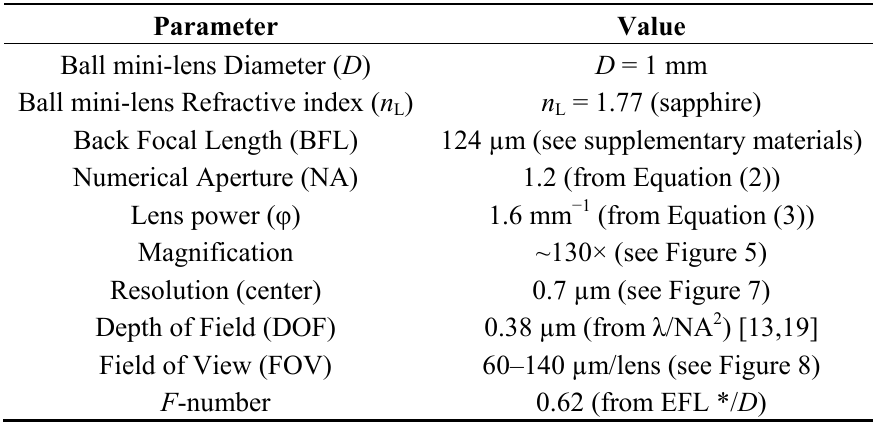
Table 1. Properties of µOIL